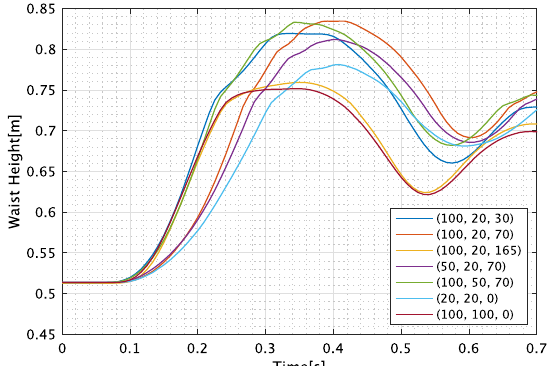
Fig. 13 Box-and-whisker diagram showing the highest point reached by the center of gravity (15 jumps) for each patella in the actual experiment